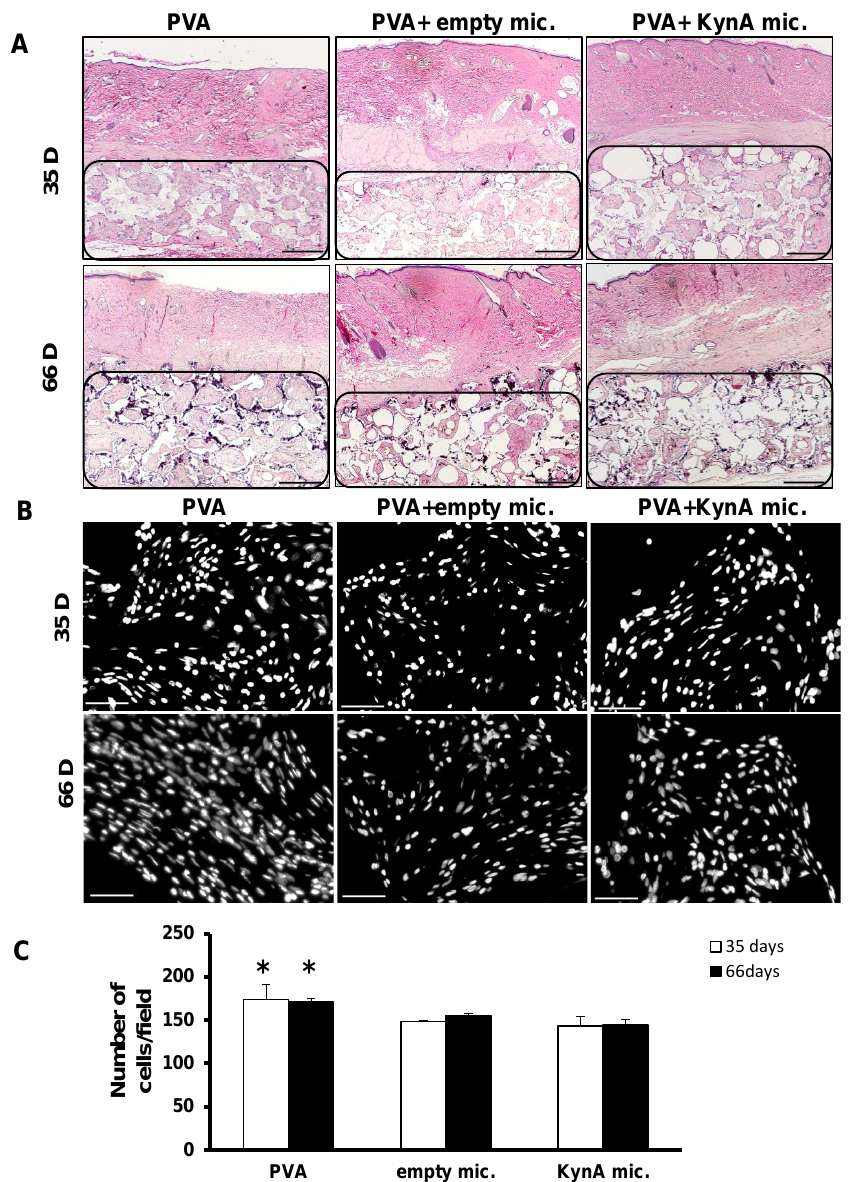
Figure 4. New tissue growth and total tissue cellularity inside PVA sponges of skin samples. ( A ) Rep- resentative sections of skin samples harvested after 35 and 66 days and stained with H&E. Granulation tissue grown inside of the PVA sponges (region marked by drawing) in all three groups: (i) PVA alone, (ii) PVA + empty microspheres, and (iii) PVA + KynA microspheres at × 20 magnification. Scale bar = 1 mm. ( B ) Tissue cellularity inside PVA sponges in sections of PVA alone, PVA + empty micro- spheres, and PVA + KynA microspheres at 35 and 66 days, stained with DAPI, at × 200 magnification. Scale bar = 50 µ m. ( C ) Average number of total cells per field at day 35 (open bars) and day 66 (solid bars) in the PVA alone, PVA + empty, and PVA + KynA microspheres. Data represent the mean ± SD for n = 4, * Statistical significance, p <